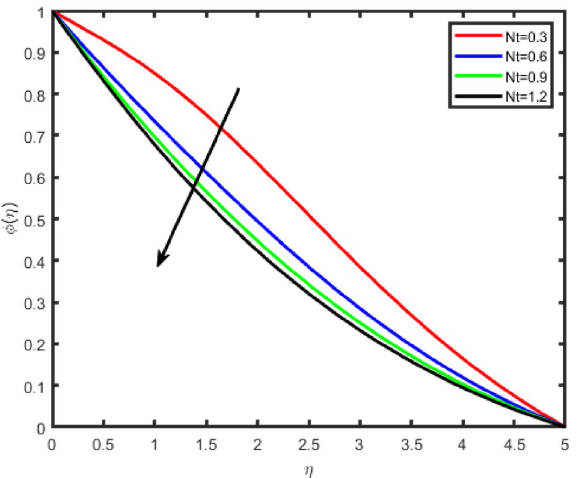
Figure 23. Effect of thermophoresis parameter (Nt) on concentration ϕ(η).